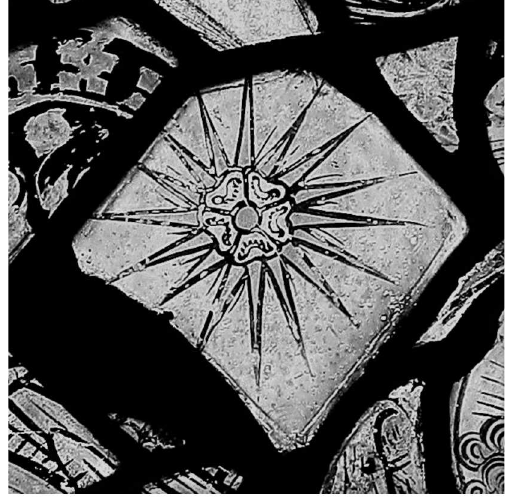
Figure 3. A rose en-soleil from a late fifteenth-century window at All Saints church, Bale, Norfolk (photograph by Mike